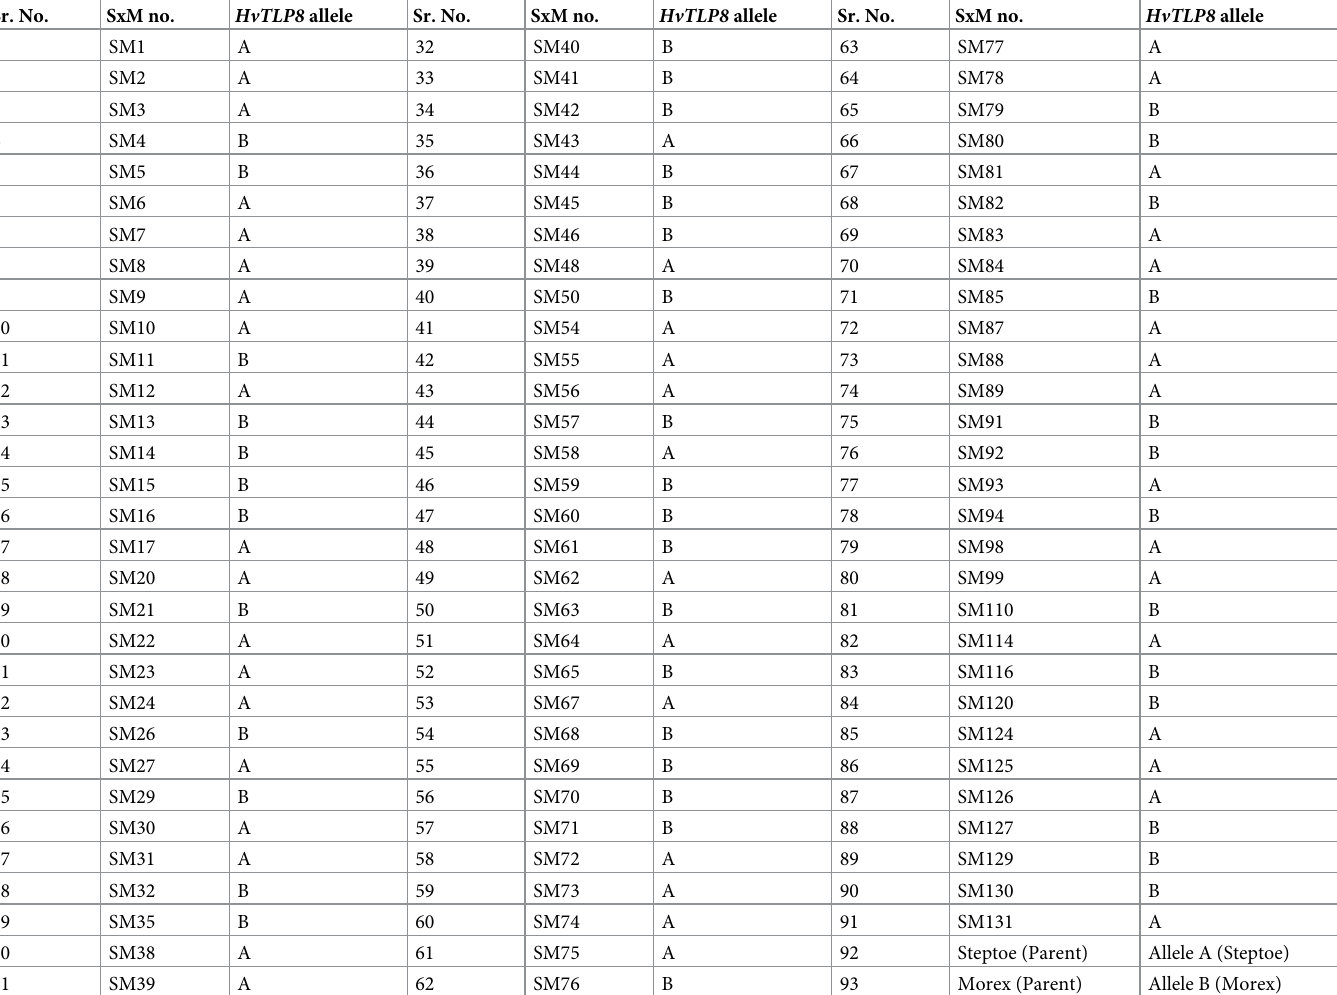
Table 3. Information about the S x M lines and HvTLP8 allele variation in the S x M DH mapping population. Sr. No. SxM